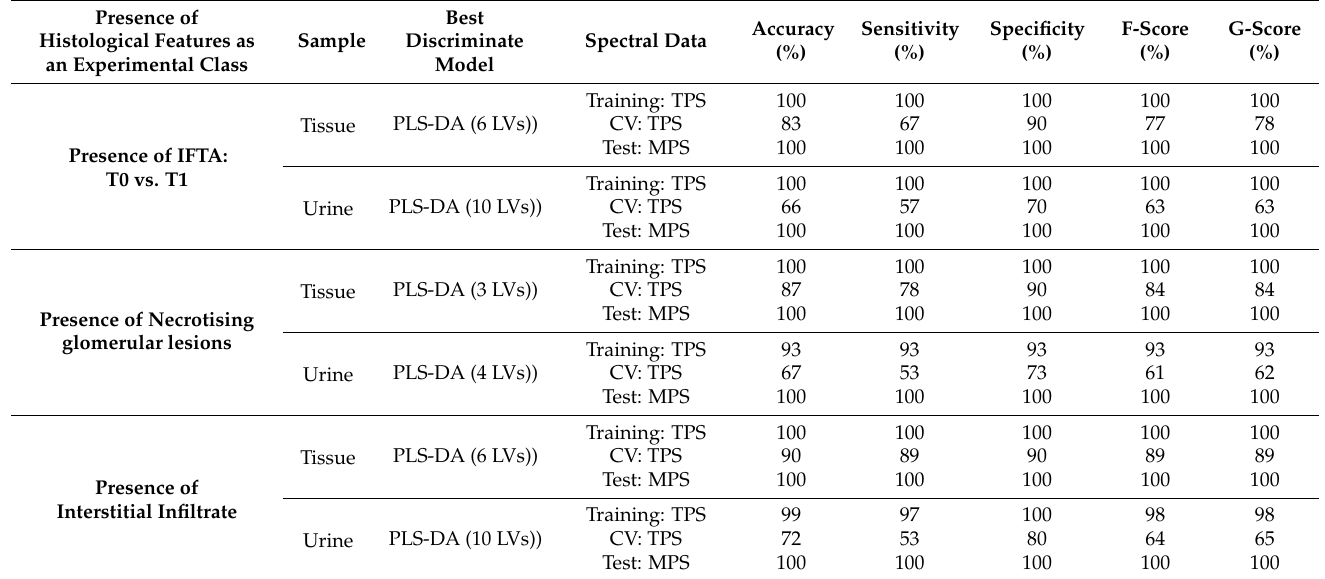
Table 3. Classification model performance according to histological data: comparative results for paired tissue & urine samples (n =